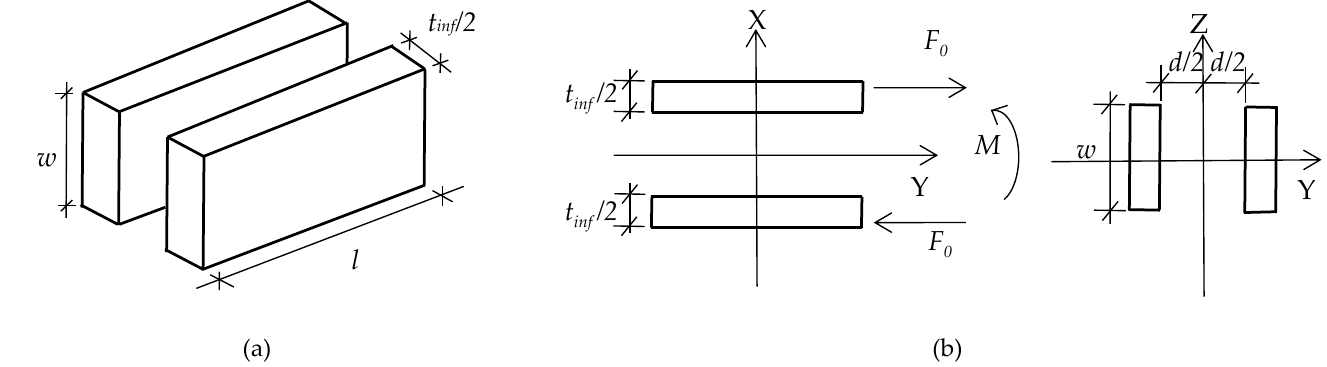
Figure 3. Details of the central element: ( a ) set of two fiber section; ( b ) analysis of section force.